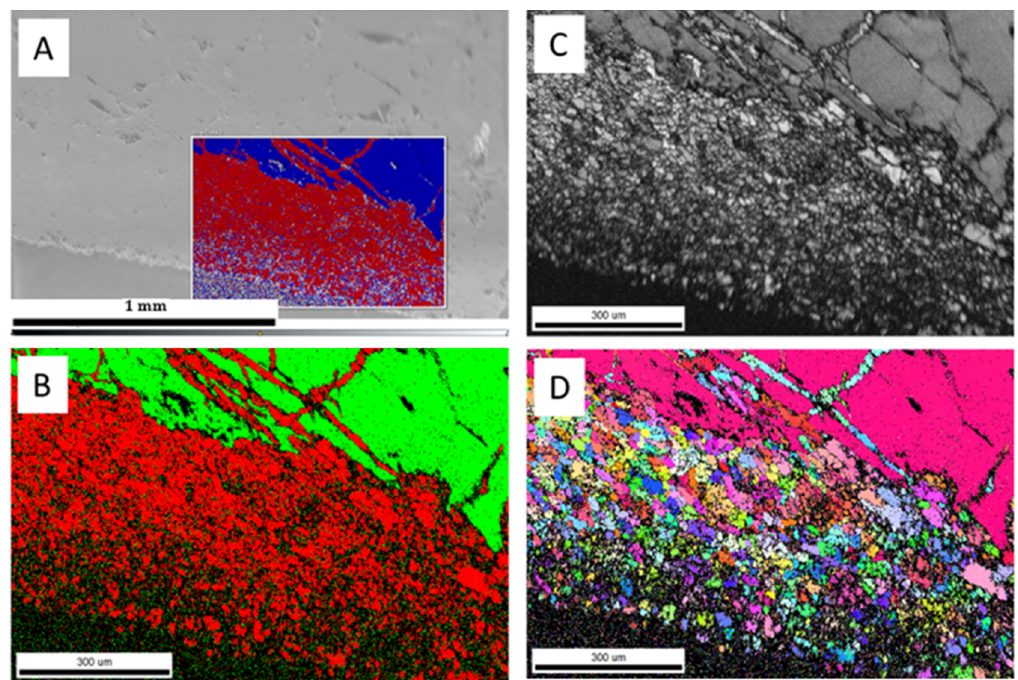
Figure 5. SEM and EBSD images of carbonates (sample 52* # ) including ( A ) SEM image of aragonite grain; ( B ) EBSD phase map (calcite is red, aragonite is green); ( C ) diffraction intensity map; ( D ) EBSD crystallographic orientation map of aragonite and calcite micro-crystals, with different-colored grains indicating the different orientations of newly formed calcite.